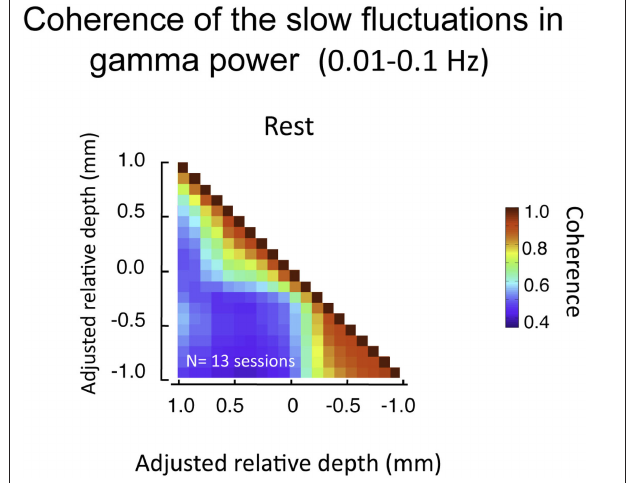
Figure 8 | Pair-wise coherence of the slow fluctuations in gamma power computed for all sessions (lasting 20 min each). Data presented in same format as Figure 7 , but now pertaining to 0.01–0.1 Hz fluctuations in the magnitude of the gamma-range LFP activity. Note these fluctuations show moderate background coherence (i.e., the blue in the plot is roughly 0.5). However, as with the voltage coherence shown above, the power coherence is highest within the same laminar compartment.